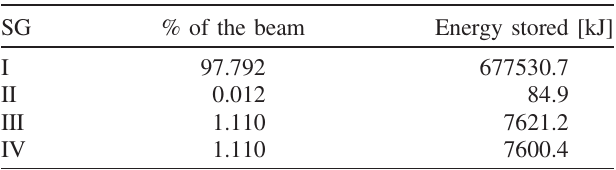
TABLE IV. Beam fraction and the corresponding energy stored for each SG with respect to the HL-LHC full beam.